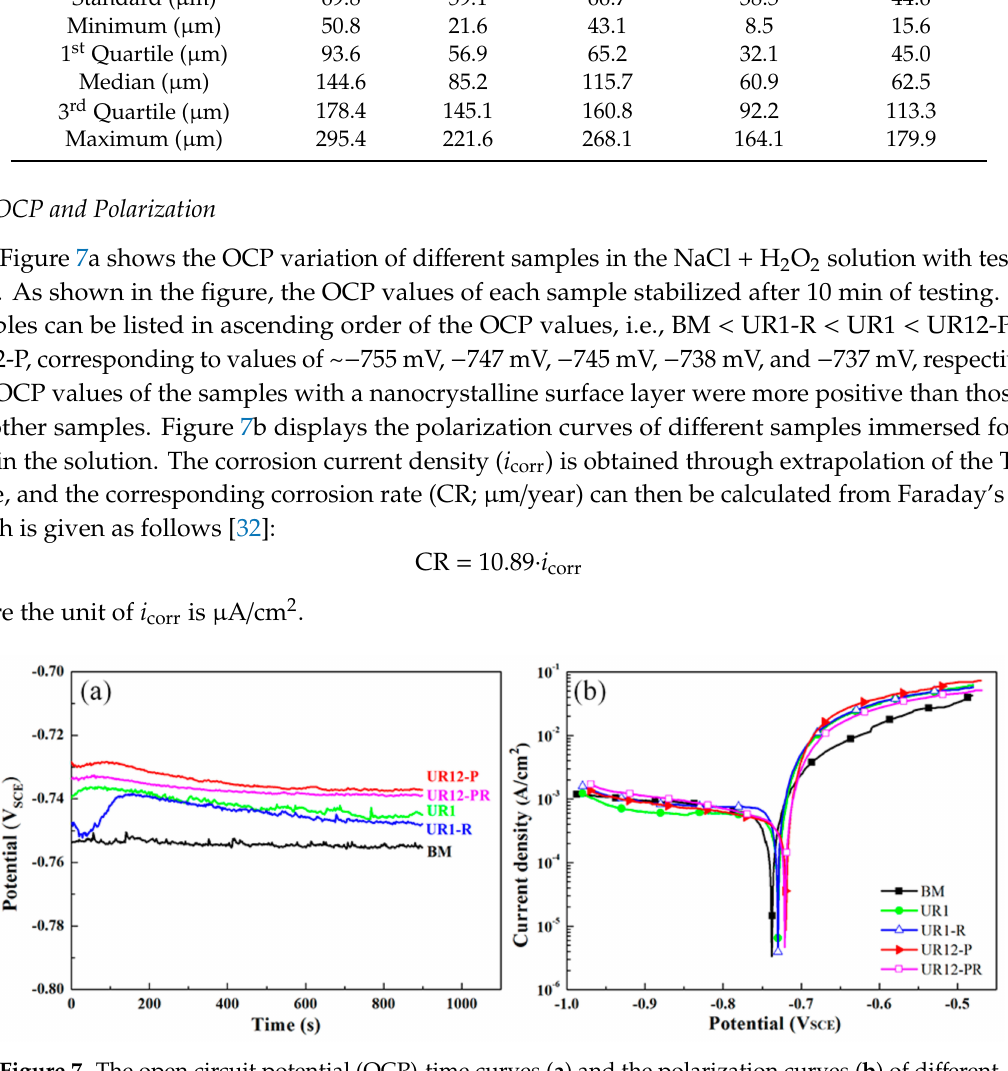
Figure 7. The open circuit potential (OCP)-time curves ( a ) and the polarization curves ( b ) of di ff erent samples immersed in the NaCl + H 2 O 2